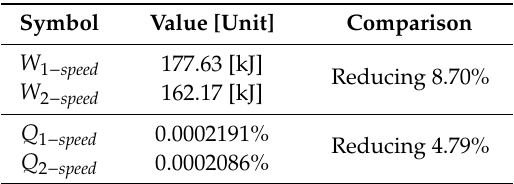
Figure 9. Capacity degradation and energy consumption simulation results of batteries with di ff erent gearboxes. Table 6. Simulation results of di ff erent